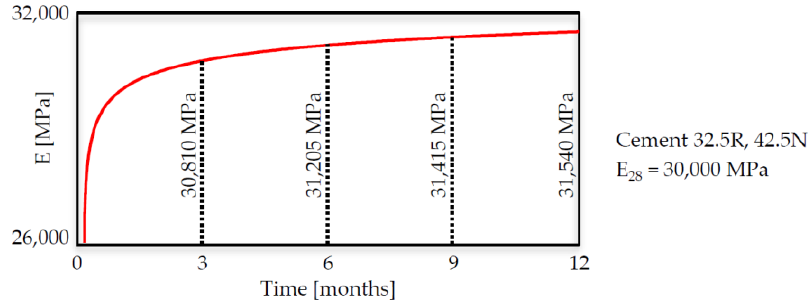
Figure 3. Variation of elastic modulus over time (calculated following [61]).